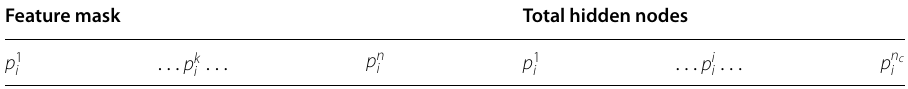
Table 3 Particle representation of ELM and PSO integration Feature